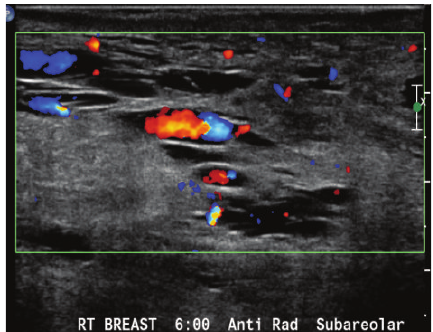
Figure 3: Breast ultrasound: 6 o’clock: huge ducts that should be going in the direction of the nipples (but there are not!). These dilated ducts end bluntly and are not connected to the outside. Therefore, the fluids and materials in them cannot decongest and stay as fluid filled.